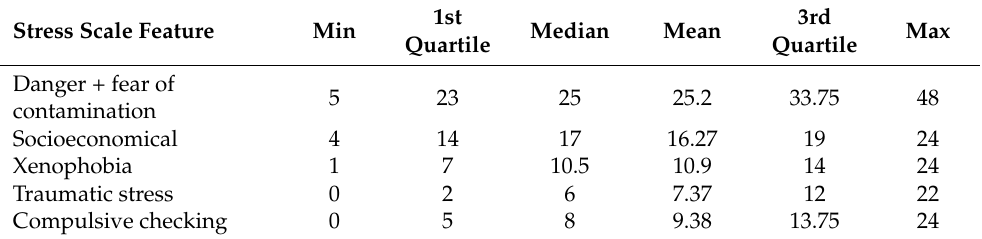
Table 2. Central tendency metrics for the adapted COVID-19 stress scale features. Stress Scale